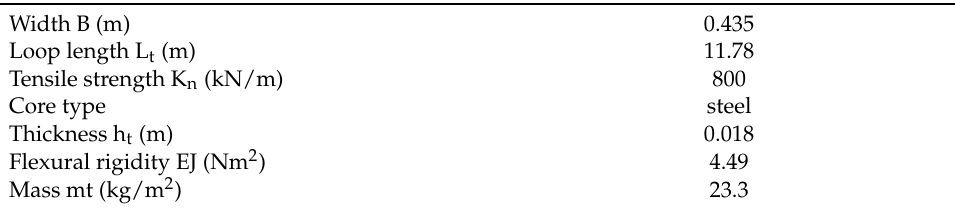
Table 1. Parameters of the tested belt